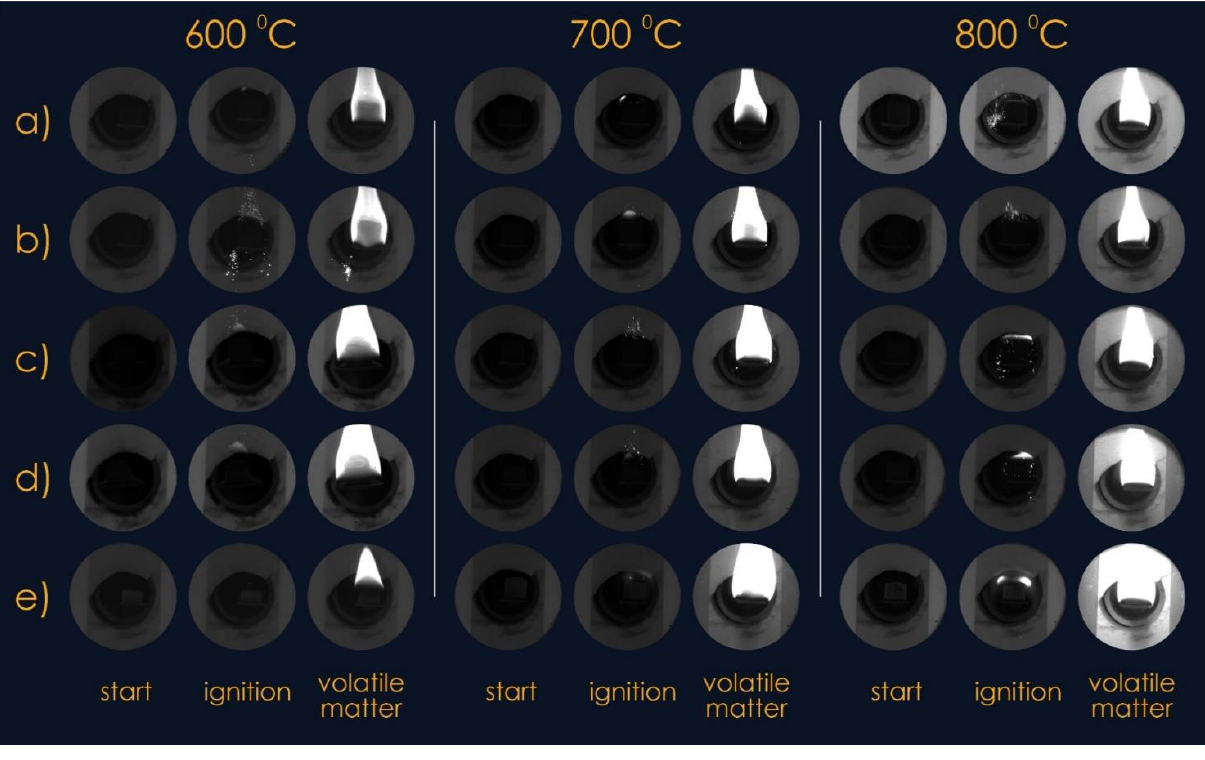
Figure 3. Video frames of the thermal decomposition process of mixed fuel pellets in the temperature range from 600 °C to 800 °C: ( a ) 100% coal; ( b ) 90% coal, 10% cedar husk; ( c ) 75% coal, 25% cedar husk; ( d ) 50% coal, 50% cedar husk; and ( e ) 100% cedar husk.